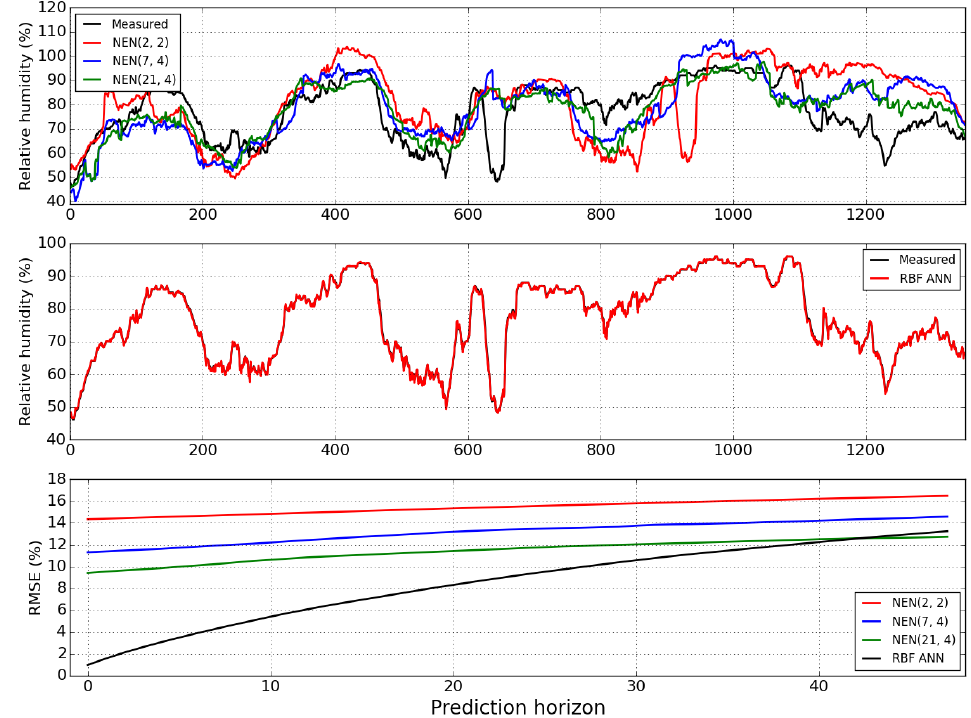
Figure 10. One-step-ahead error for the NEN algorithm ( Top ) and the RBF ANN ( Middle ), considering the last 1350 data points. Evolution of the RMSE ( Bottom ), along the prediction horizon instants, for air relative humidity forecasts obtained by the RBF model (black), and the NEN algorithm: Red (2, 2), blue (7, 4) and green (21, 4). Table 2. RMSEs of Relative